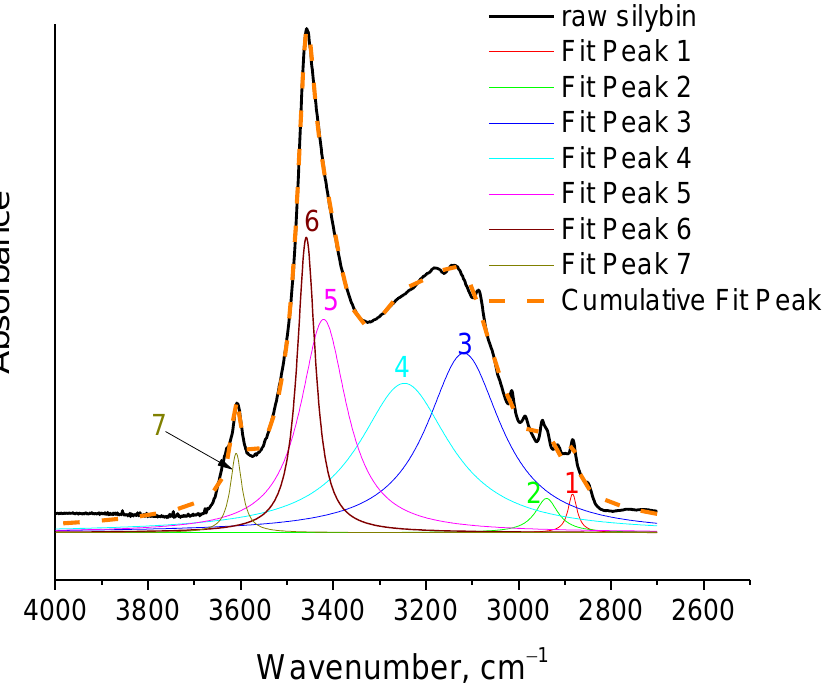
Figure 4. Curve fitting (with Lorentzian peaks) of the spectrum of raw silybin in the region 2700–4000 cm − 1 . Table 2. Wavenumbers and percentage areas of the fitted peaks, presented in Figure 4. Fitted